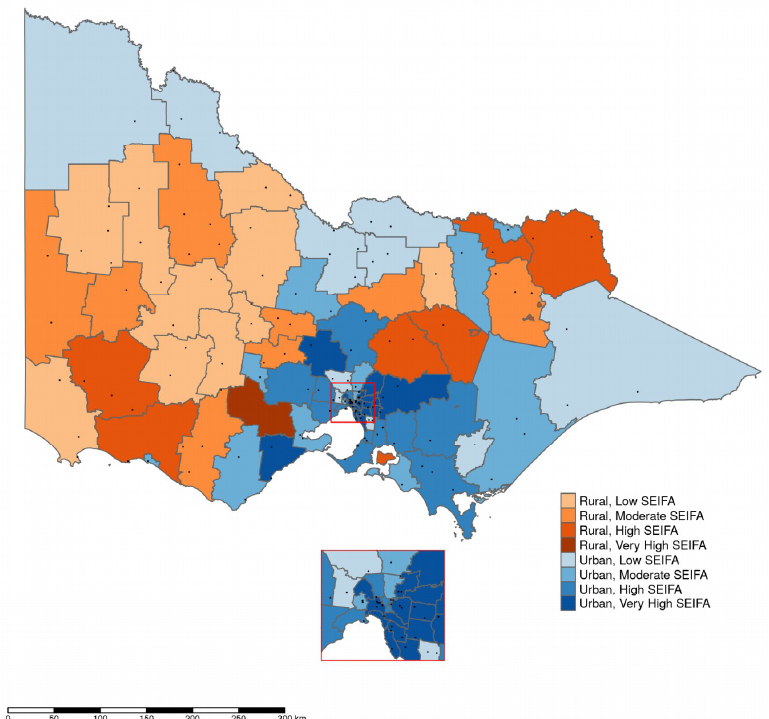
Figure 4. Dispensing of opioids in 2015 in LGAs of four SEIFA categories and rural and urban localities. Dots are pointing the location of hospitals and or